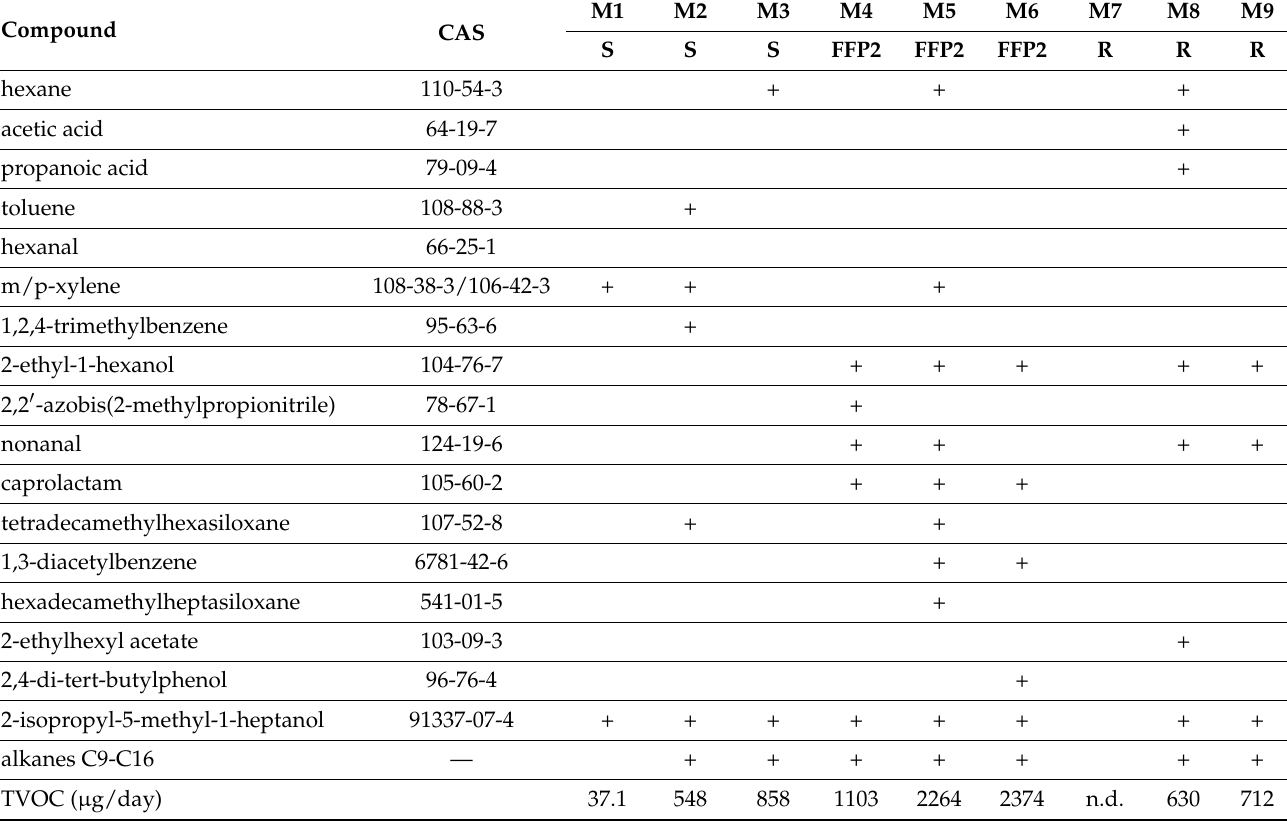
Table 3. Major VOCs identified (with concentration > 2 µ g/m 3 ) and TVOC ( µ g/day) concentration for nine facemasks analyzed of 3 types: surgical (M1–M3), FFP2 (M4–M6) and reusable